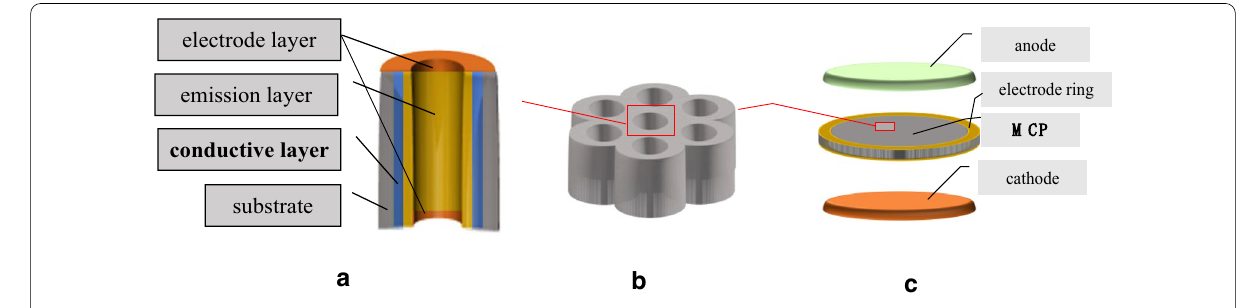
Fig. 5 ALD–MCP resistance test schematic diagram